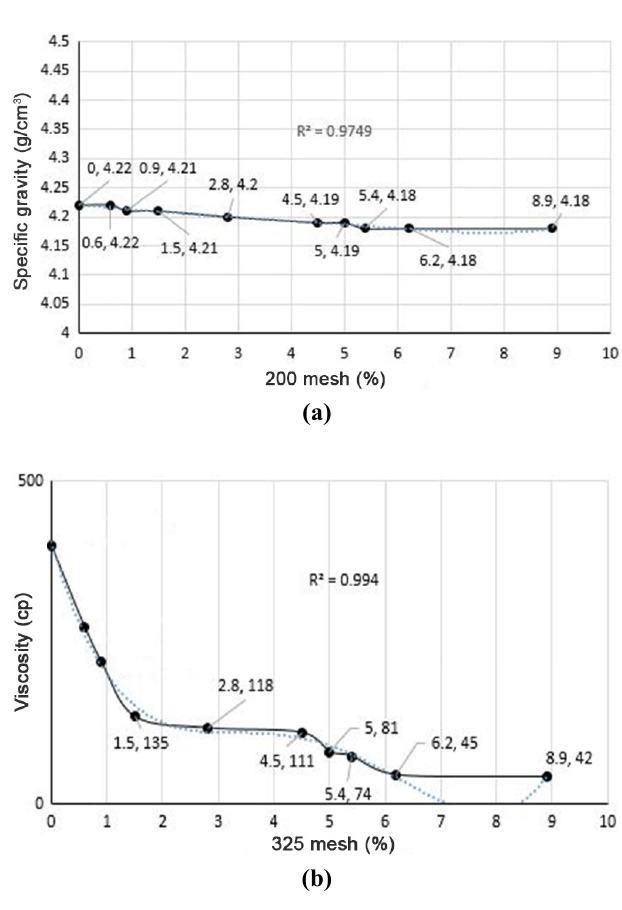
Fig. 2. The effect of graining on specific gravity (82 °C) of (a) 200 mesh and (b) 325 mesh.